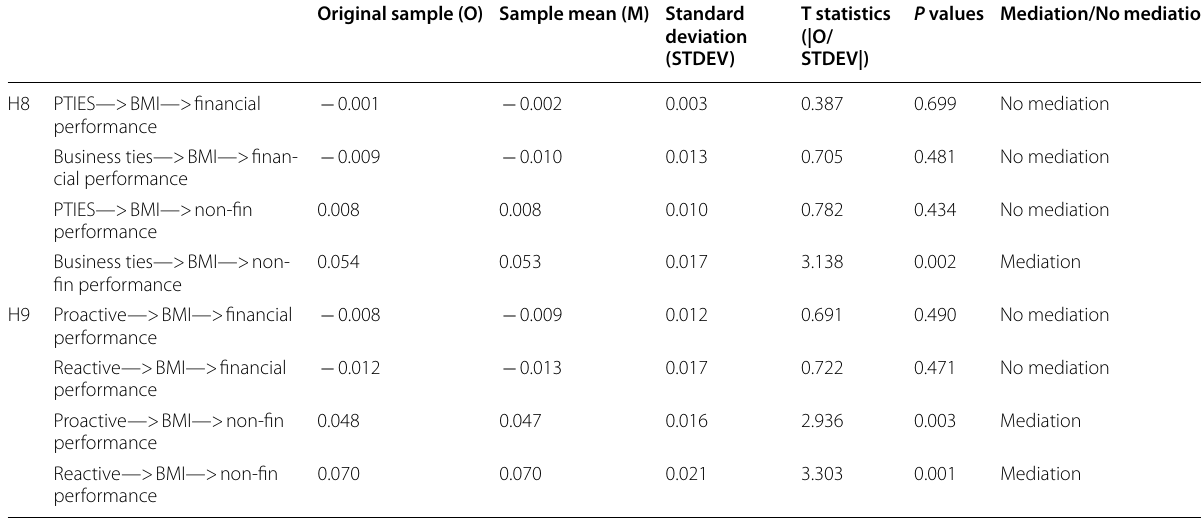
Table 5 Specific indirect